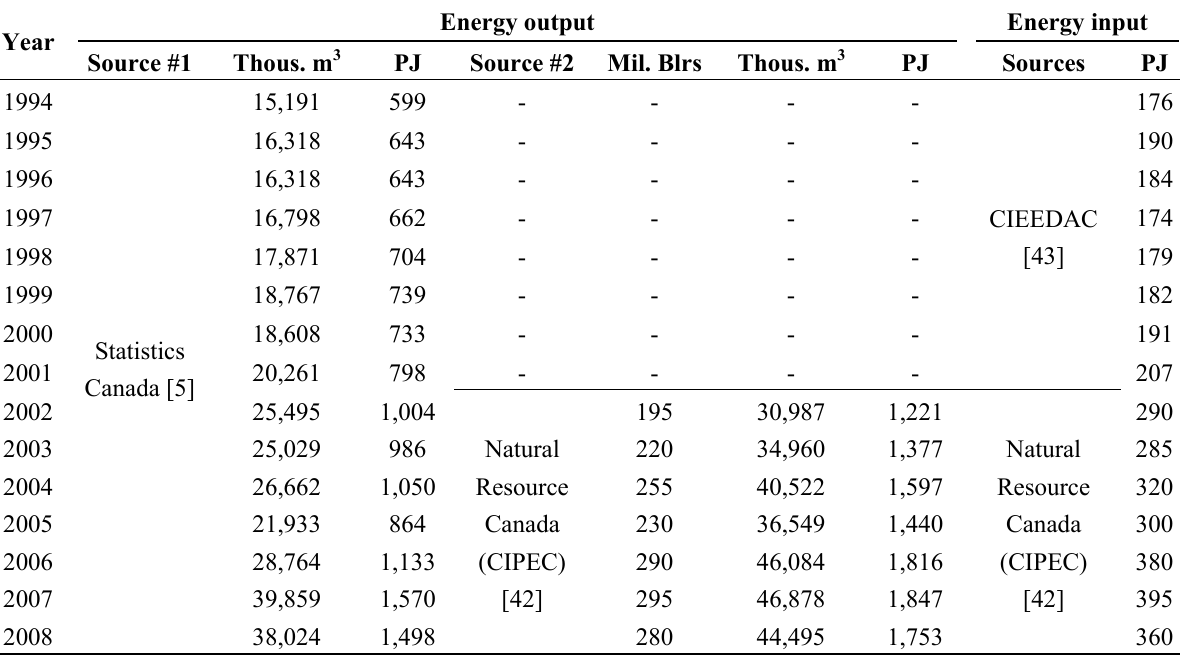
Table 5. Energy use and production for tar sands from surface mining